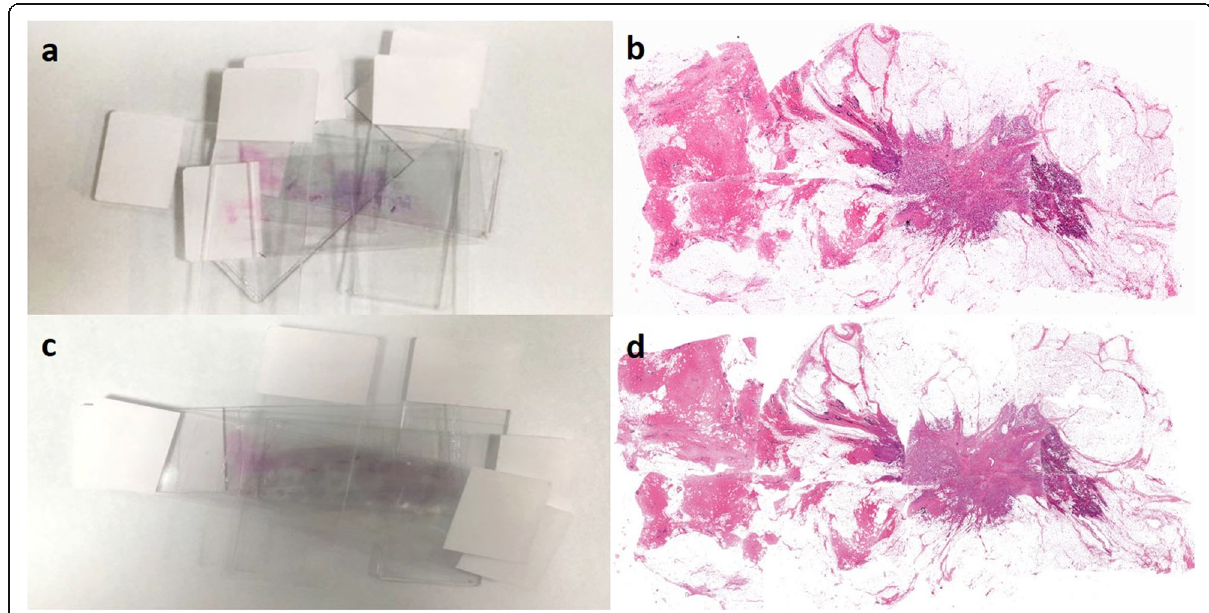
Fig. 3 Case demonstration of conventional manual stack splicing and software-assisted stitching. a and c are the largest sections of the tumor bed obtained by two pathologists (A and B) through conventional stack splicing methods, respectively. b and d are the virtual large slides obtained by pathologists A and B using software-assisted stitching methods, respectively